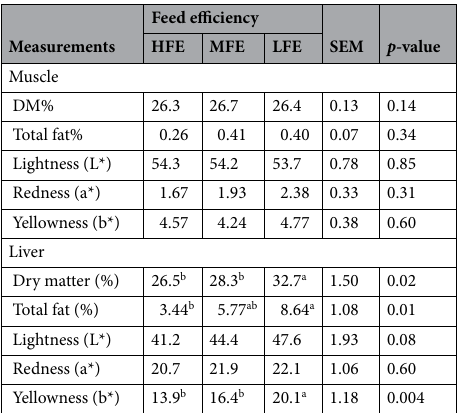
Table 3. Differences in the muscle and liver composition of individually housed ISA Brown hens aged 45 weeks old, ranked based on feed to egg efficiency (n = 30; 10 hens per group). HFE, high feed efficiency; MFE, medium feed efficiency; LFE, low feed efficiency; SEM, standard error of mean; abc —means within rows not sharing a common suffix are significantly different at the 5% level of probability.